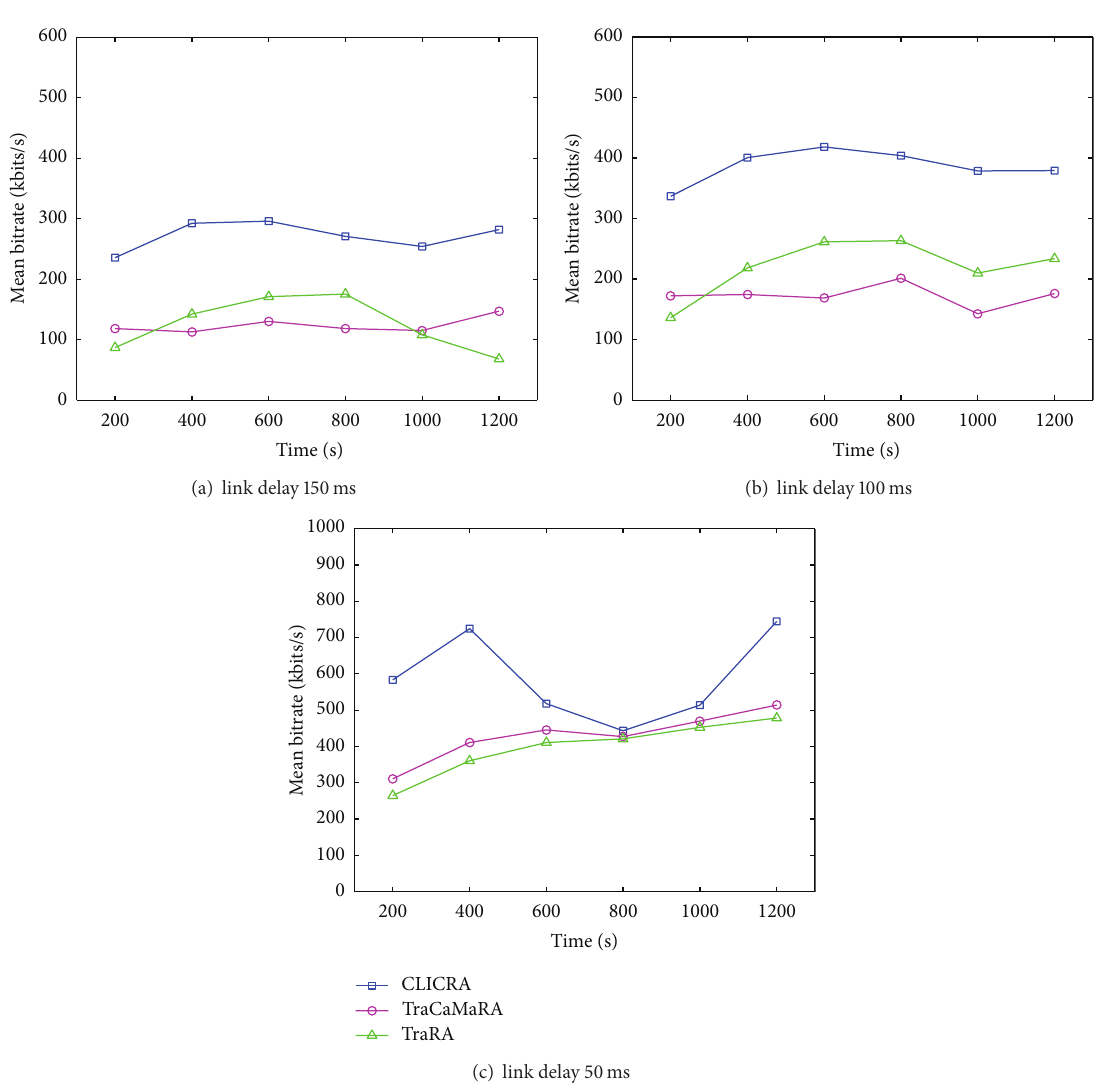
Figure 8: Received mean bitrate over simulation time for receive window 60Kbytes.